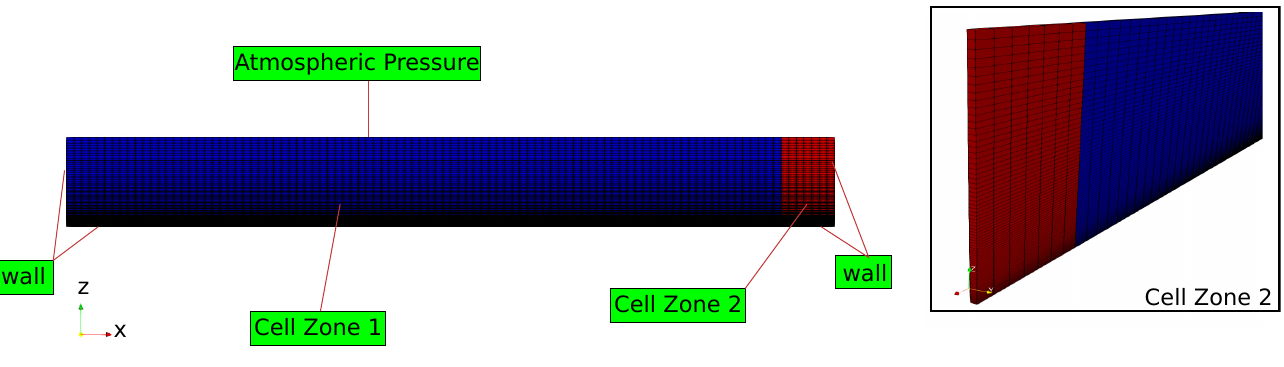
Figure 10. Geometry, mesh and boundary conditions used in the numerical